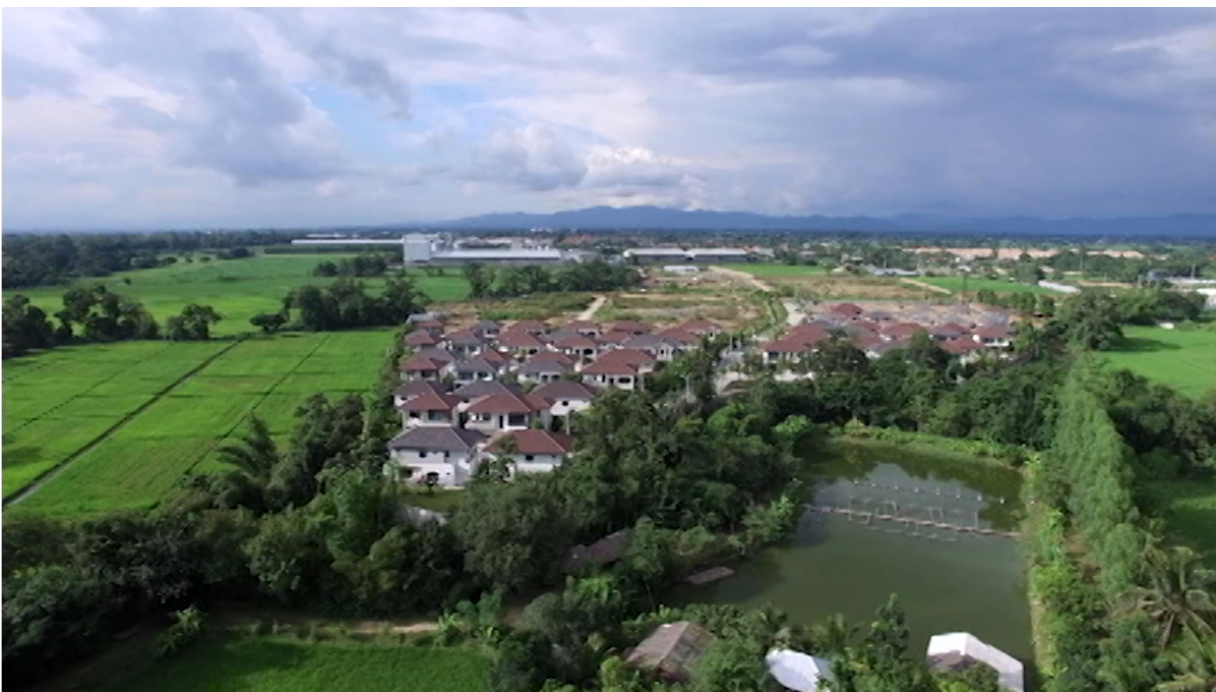
Figure 10. A high wall separates rice paddies and fish ponds from new gated community under construction within the agricultural preservation zone east of the Kuang River. Industrial food processing sheds can be seen in the background. Drone imagery: Santipab Sonboom, October 2016.